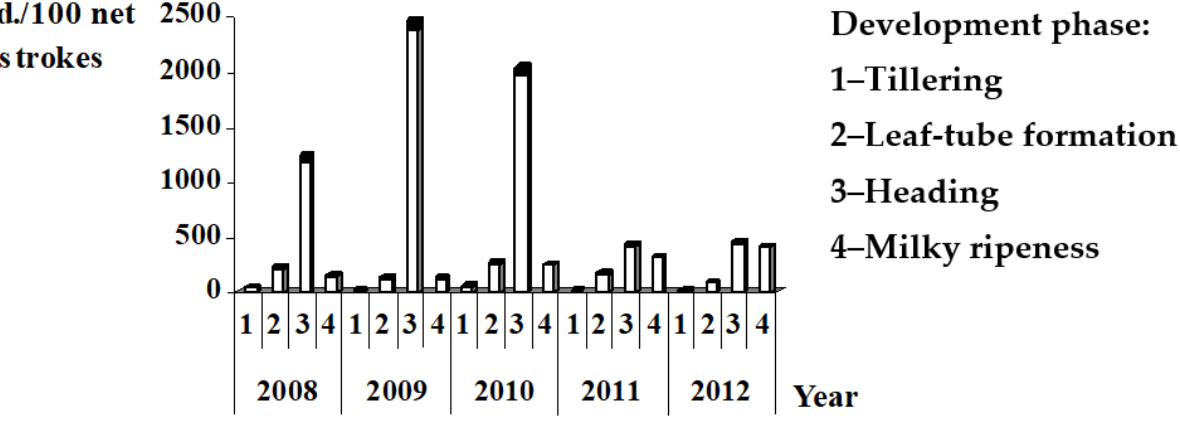
Figure 1. Abundance of adult wheat thrips and adult predatory and striped thrips in agrocenoses of winter wheat, ind./100 net strokes.